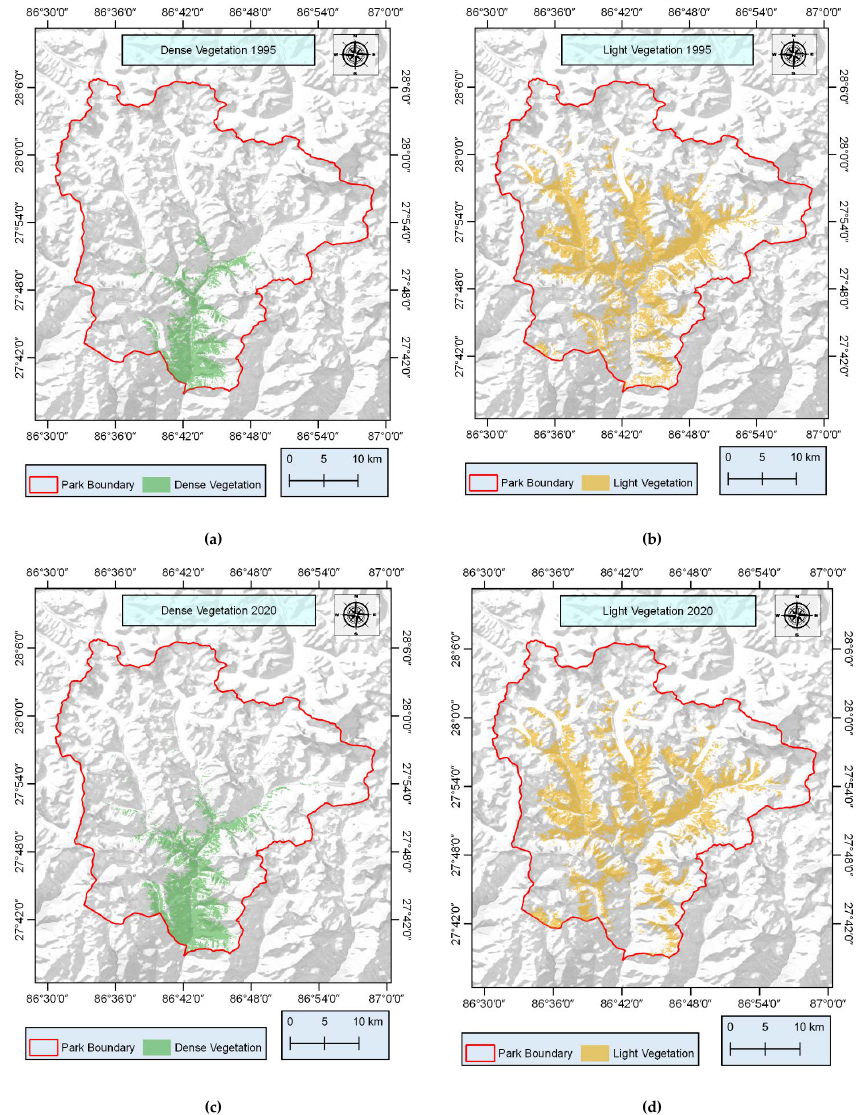
Figure 8. Alpine vegetation: ( a ) dense vegetation in 1995; ( b ) light vegetation 1995; ( c ) dense vegetation in 2020; ( d ) light vegetation in